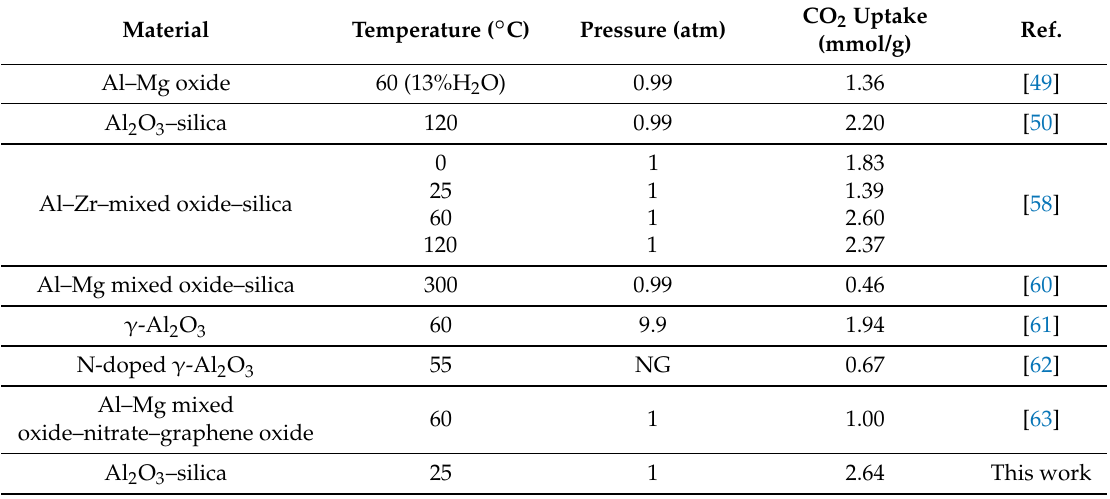
Table 2. Comparison of the CO 2 sorption data for different alumina-based composite